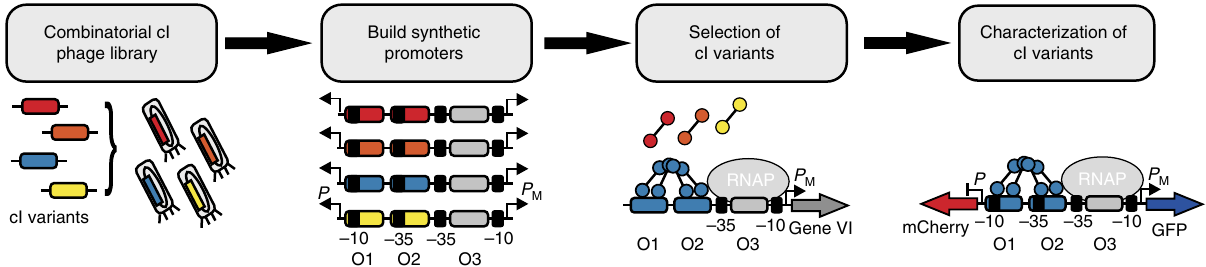
Figure 1 | Developing a set of orthogonal dual transcription factors for synthetic logic gates. Flow chart of the selection process and characterization of orthogonal transcription factor-promoter pairs. For the selection of cI variants, a new M13 phagemid-based system was developed (Fig. 2). The selected TFs were characterized, and checked for orthogonality, by a GFP and mCherry dual reporter assay employing bidirectional promoters that integrate both activation and repression